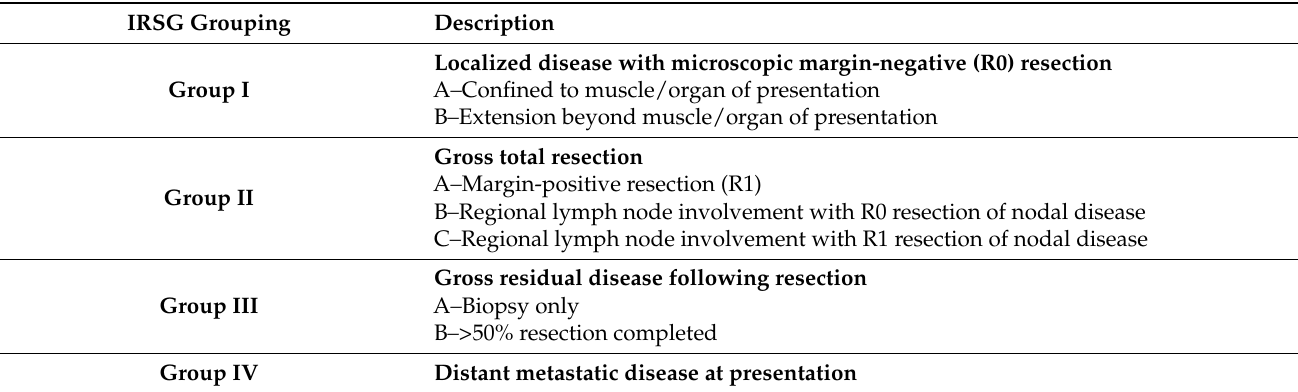
Table 2. Grouping per Intergroup Rhabdomyosarcoma Study Group (IRSG)